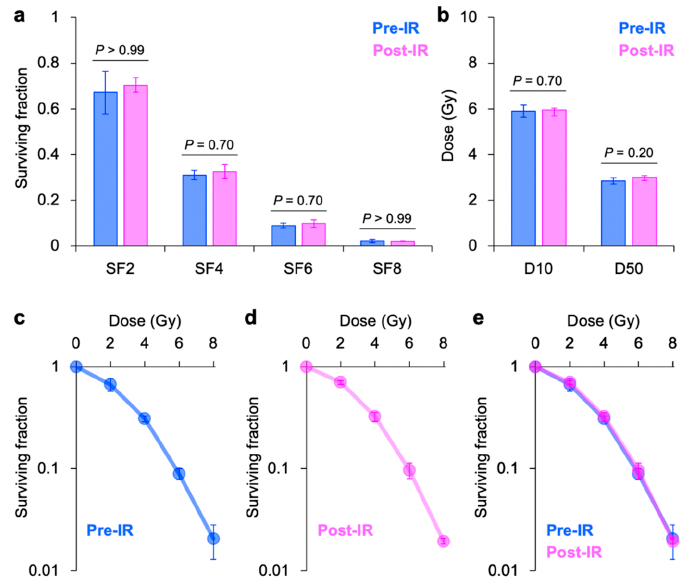
Figure 2. Clonogenic survival of X-ray-irradiated human salivary gland (HSG) cancer cells assessed using pre-IR or post-IR plating methods. ( a ) SF 2 , SF 4 , SF 6 , and SF 8 . ( b ) D 10 and D 50 . p -values were determined using the Mann–Whitney U-test. ( c ) Survival plots from pre-IR-plated cells. ( d ) Survival plots from post-IR-plated cells. ( e ) Survival plots from pre-IR (blue) or post-IR (violet) plating methods. Graphs are presented in 50% translucent colors; therefore, purple color indicates an overlap between the two plating methods. SFx indicates the survival at X Gy; Dx indicates the dose providing X% survival. Error bars indicate standard deviation.